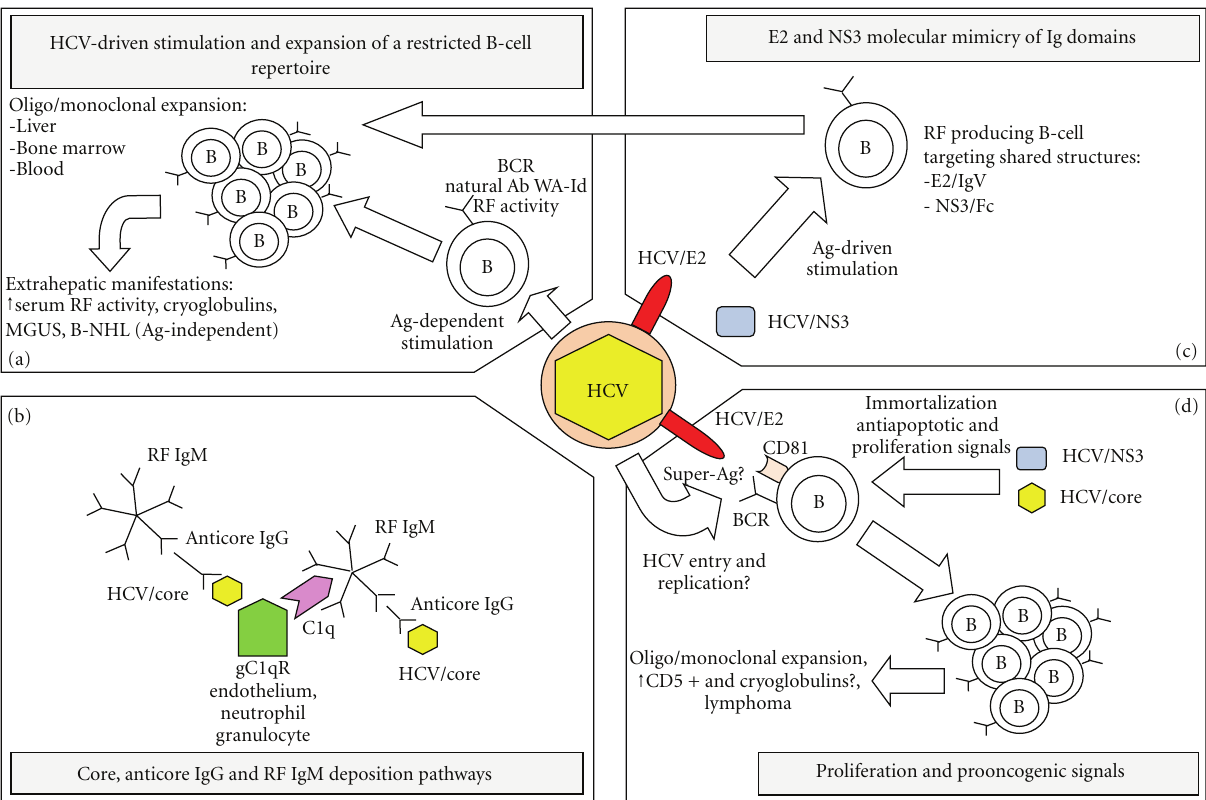
Figure 1: Proposed etiopathogenetic mechanisms involved in the origin of HCV-induced MCII. (a) Direct involvement of HCV infection and of specific HCV Ags in the emergence and maintenance of B-cell expansions, more frequently occurring in the liver and mostly involving RF-producing B cells. This B-cell repertoire is therefore limited and likely coded by few germline genes. These clonal expansions are invariably associated with extrahepatic manifestations, including high serum levels of polyclonal rheumatoid factor activity, cryoglobulins, monoclonal gammopathy of undetermined significance (MGUS), and eventually frank B-cell non-Hodgkin lymphoma (B-NHL). (b) The wide expression of gC1qR on the surface of blood cells, like neutrophil granulocytes, as well as of endothelial cells favors their specific binding to immune complexes containing HCV core protein and may determine their cold precipitation. Alternatively, IgM molecules are good acceptors of C1q, whose binding site is on their Fc portion and, if endowed with RF activity, may precipitate in presence of IgG molecules with specific anticore activity. (c) HCV/E2- and HCV/NS3-induced proliferation and expansion of B-cell clones producing cross-reactive Ig recognizing structures shared between these Ags and discrete Ig regions (i.e., Fc or IgV domains). (d) HCV might initiate a multistage process of lymphomagenesis by replicating in lymphoid cells and expressing proteins that associate with host cell-encoded tumor- suppressing proteins, thereby abrogating their cell-cycle checkpoint functions and predisposing the cell to genetic instability. Alternatively, HCV/E2 binding to CD81, as part of the CD19/CD21/CD81, might provide a strong proliferation signal. Moreover, HCV/E2 could behave as a B-cell super-Ag and directly stimulate proliferation and oligo/monoclonal expansion through its direct binding to BCRs encoded by specific IgV